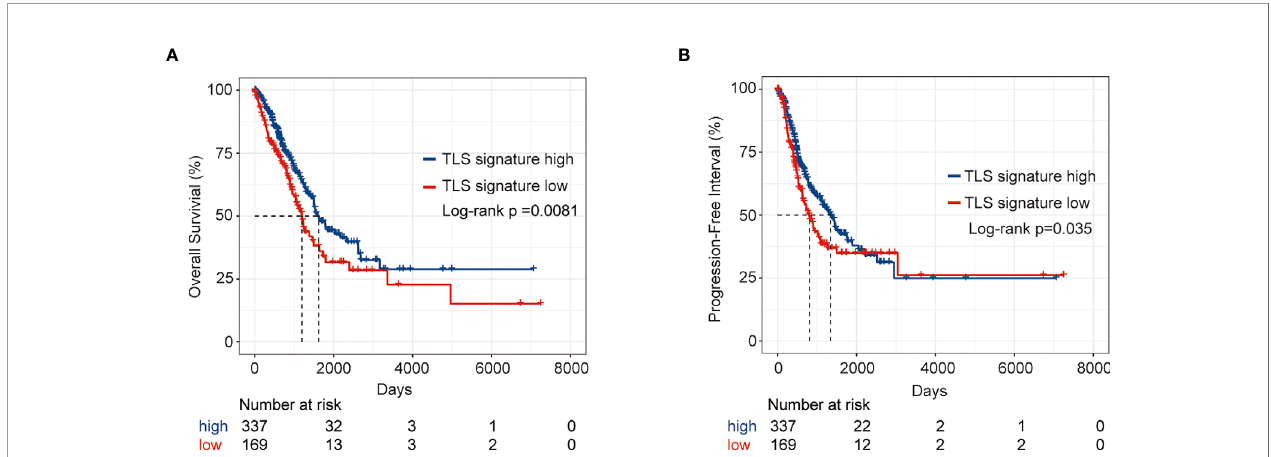
FIGURE 1 | Survival analysis of LUAD patients in the TLS signature high and low groups from the TCGA cohort. (A) Kaplan – Meier plots of overall survival difference between tumors with TLS high (n = 337) and low groups (n = 169) in LUAD; (B) Kaplan – Meier plots of progression free survival difference between tumors with TLS signature high (n = 337) and low groups (n = 169) in LUAD.